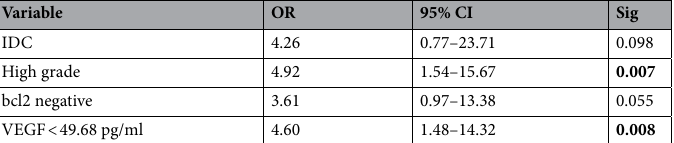
Variable OR 95% CI Sig IDC